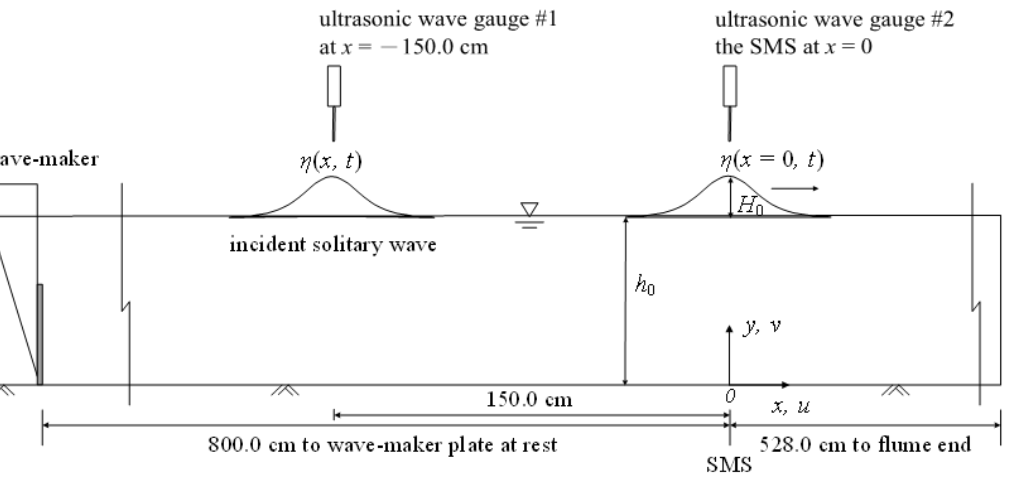
Figure 1. Schematic diagram showing a solitary wave propagating over a horizontal bed, two wave gauges, the ( x , y ) coordinate system, and ( u , v ) velocity components.